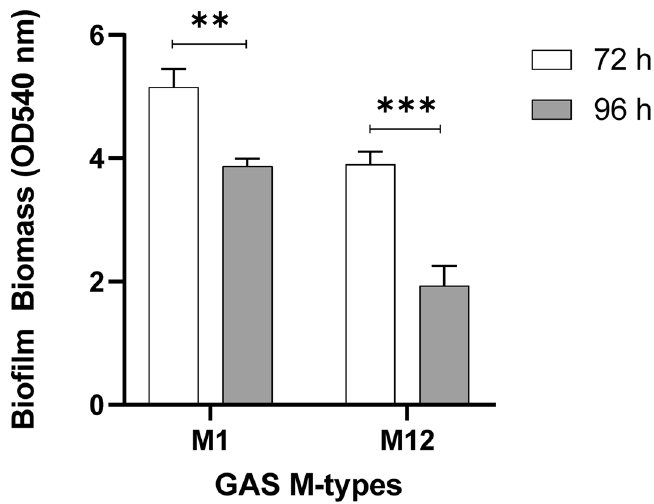
Figure 5. 72 h is an optimal period for GAS biofilm formation. M1 and M12 were assessed for GAS biofilm formation at 72 and 96 h. 72 h yielded significantly more biofilm than 96 h. Biofilm biomass was determined via crystal violet staining. Monolayers with THY (no GAS biofilm) served as media sterility controls and background staining controls, with absorbance values subtracted from those of biofilm samples. Data represents mean ± SEM, ** (P ≤ 0.01) and *** (P ≤ 0.001); n = 3 biological replicates, with 3 technical replicates each.